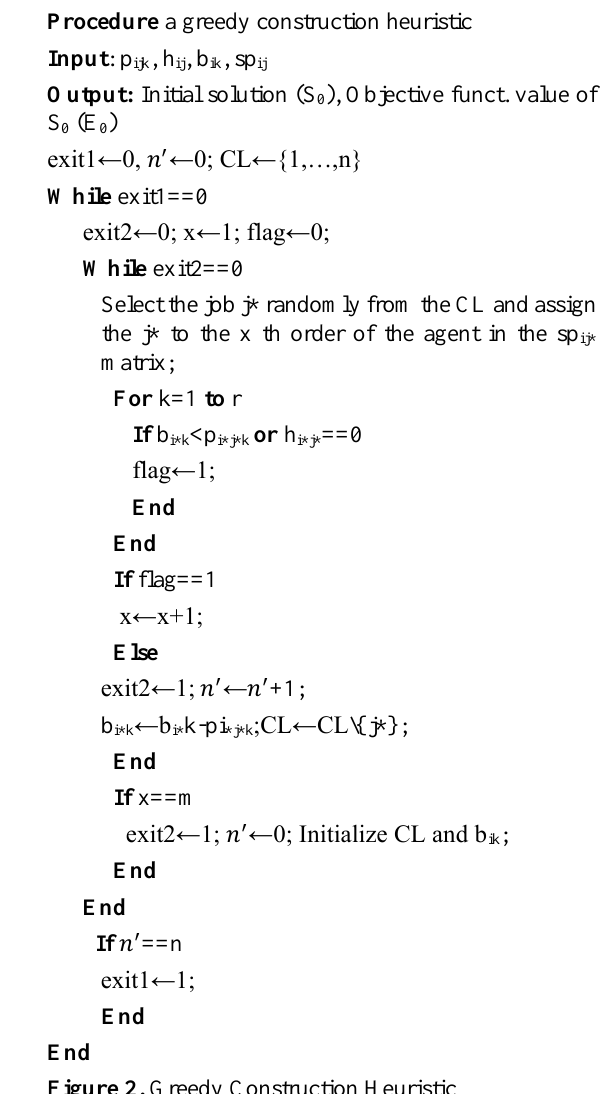
Figure 2. Greedy Construction Heuristic